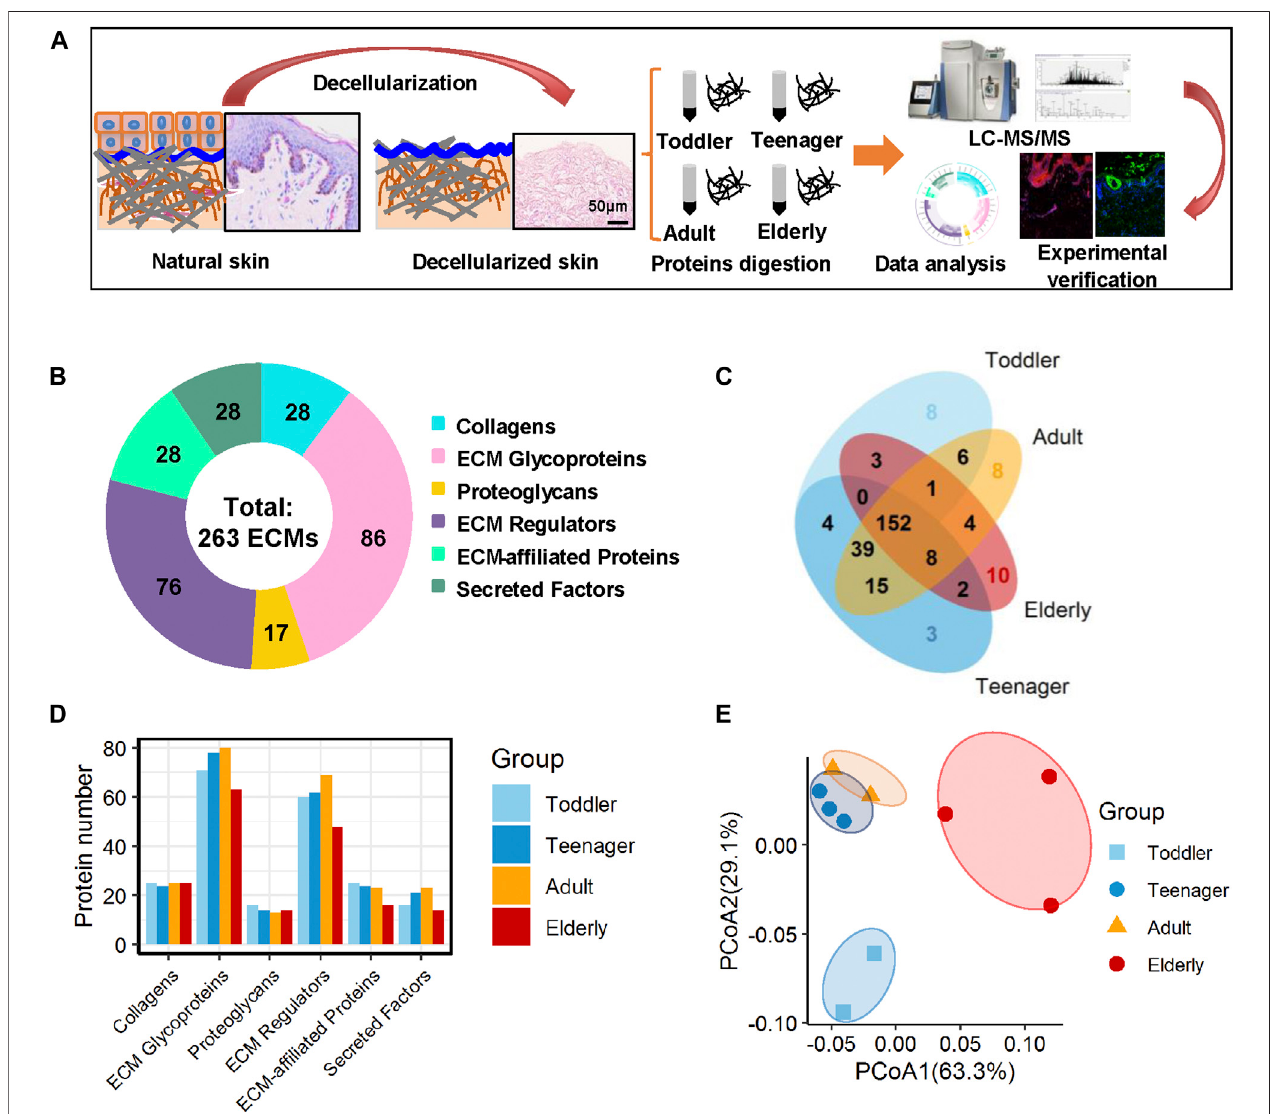
FIGURE 1 | Matrisome pro fi le of the human skin dermis. (A) General work fl ow of the whole experimental design, including decellularization, mass spectrometry- basedquantitativeproteomics,bioinformaticsanalyses,andexperimentalveri fi cation. (B) SixtypesofECMproteins(collagens,ECMglycoproteins,proteoglycans,ECM regulators, ECM-af fi liated proteins, and secreted factors) expressed at four ages (toddler, teenager, adult, and elderly). Pie charts represent the proportion of the six components (collagens, ECM glycoproteins, proteoglycans, ECM regulators, ECM-af fi liated proteins, and secreted factors) that make up the matrisome in the humanskindermis. (C) Overlap ofECMproteinsintheskinscaffoldsoffourages(toddler, teenager,adult,and elderly). (D) Histogramshowsthenumber ofthesixECM components identi fi ed at four age stages. (E) PCoA analysis of the samples at four ages (toddler, teenager, adult, and elderly) based on their ECM pro fi le. The technical repeats were produced for each sample, represented by different colored points in the fi gure.